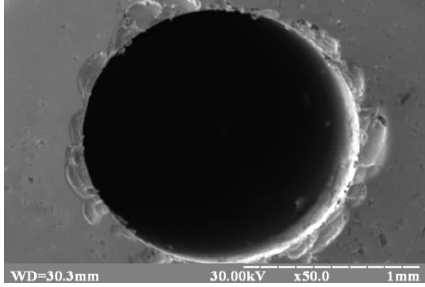
Fig. 4. The photomicrography of the worn edges of the